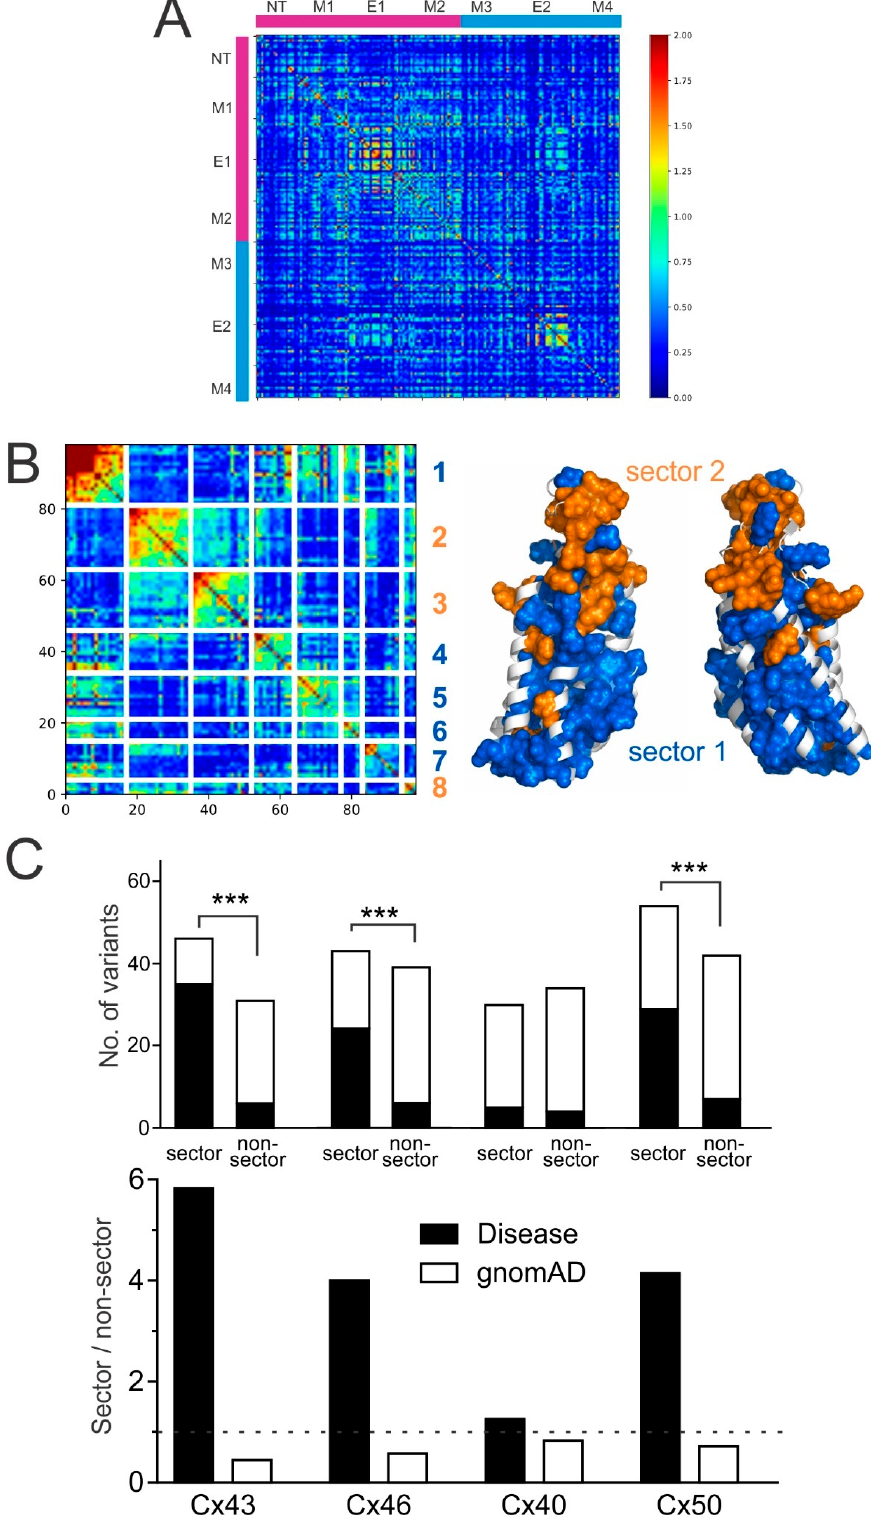
Figure 9. Statistical coupling analysis of connexin sequences. ( A ) Python-based statistical coupling analysis (pySCA) was used to obtain this evolutionary co-variation matrix on structured domains (based on Cx46 structure 6MHQ). The magenta-colored bars on the top and left illustrate the pore domain (NT, M1, E1, and M2), and similarly, the blue bars are the non-pore domain (M3, E2, and